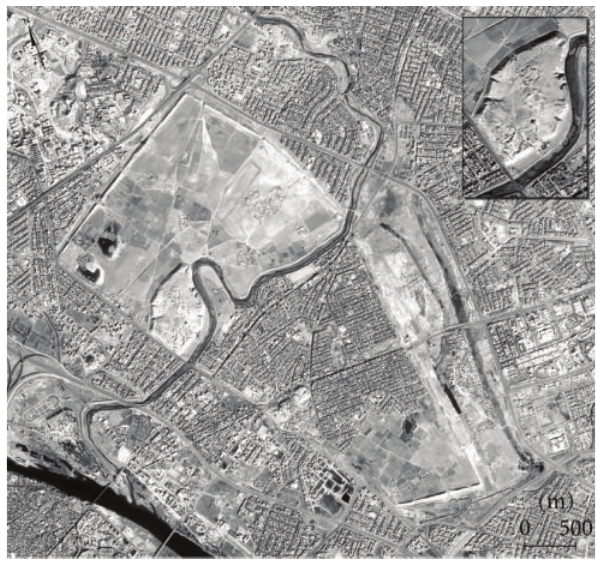
Figure 15: Nineveh in a panchromatic WorldView-1 image of 2007; an enlargement of the image shows the mound of